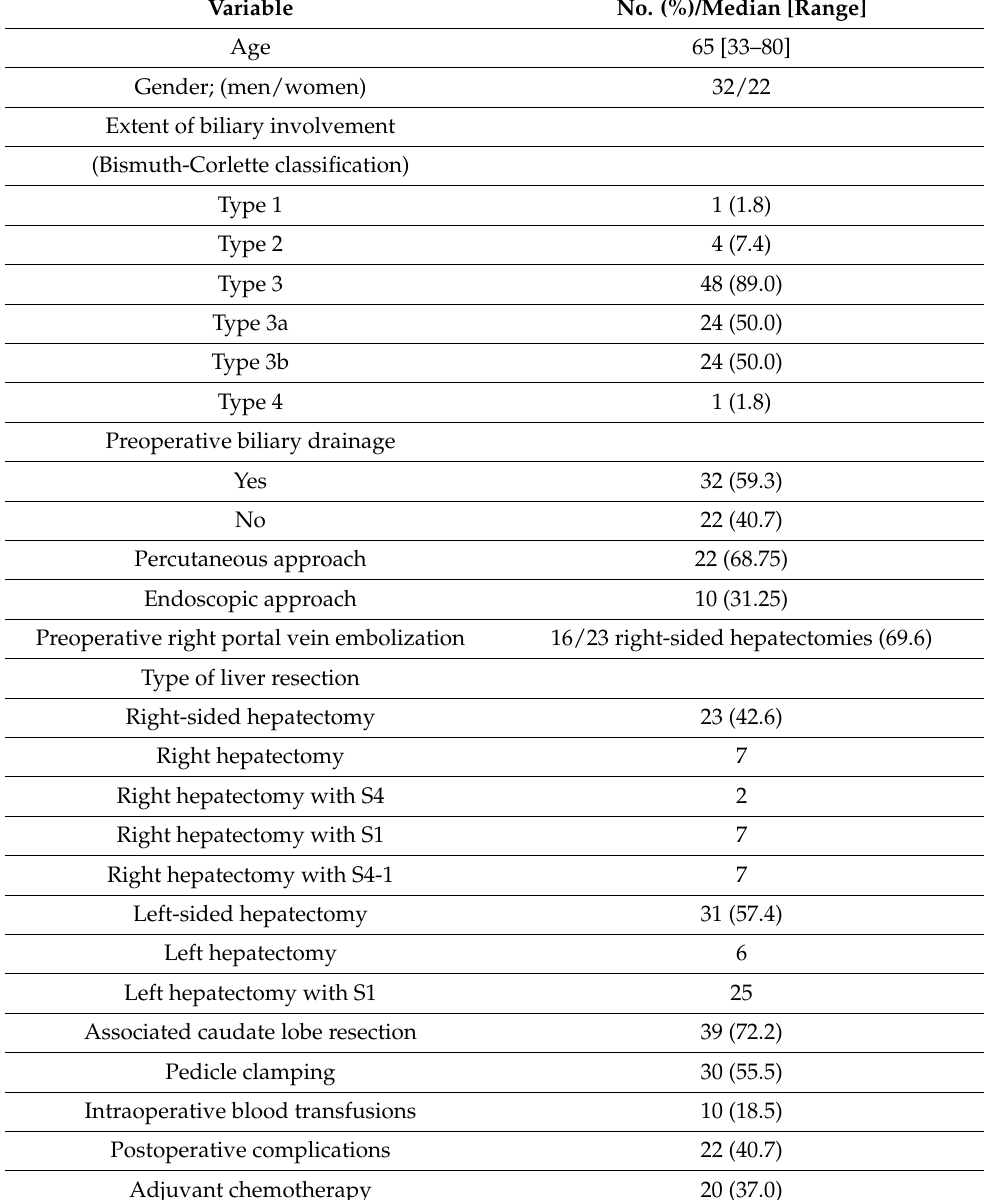
Table 2. Characteristics of the 54 resected patients for